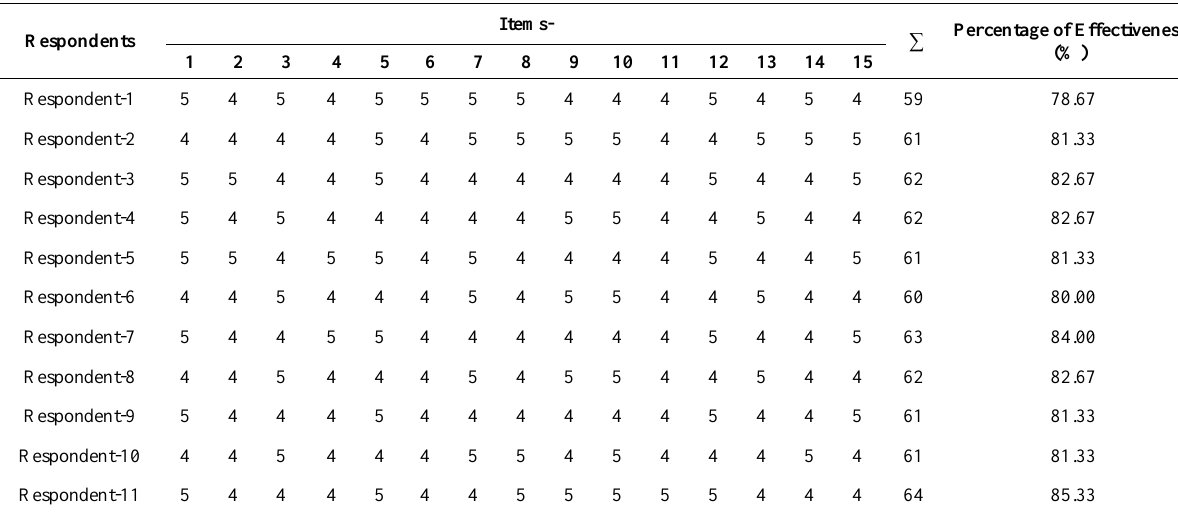
Table 4. Results of Initial Trials toward the Design of CSE-UCLA Model that Modification with Discrepancy